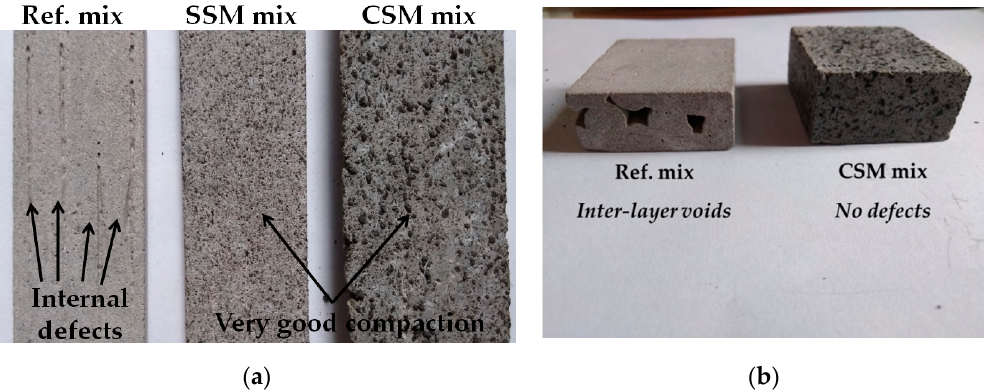
Figure 1 . Inter-layer adhesion evaluation in cementitious samples ( a ) and investigation of structural defects ( b ) .